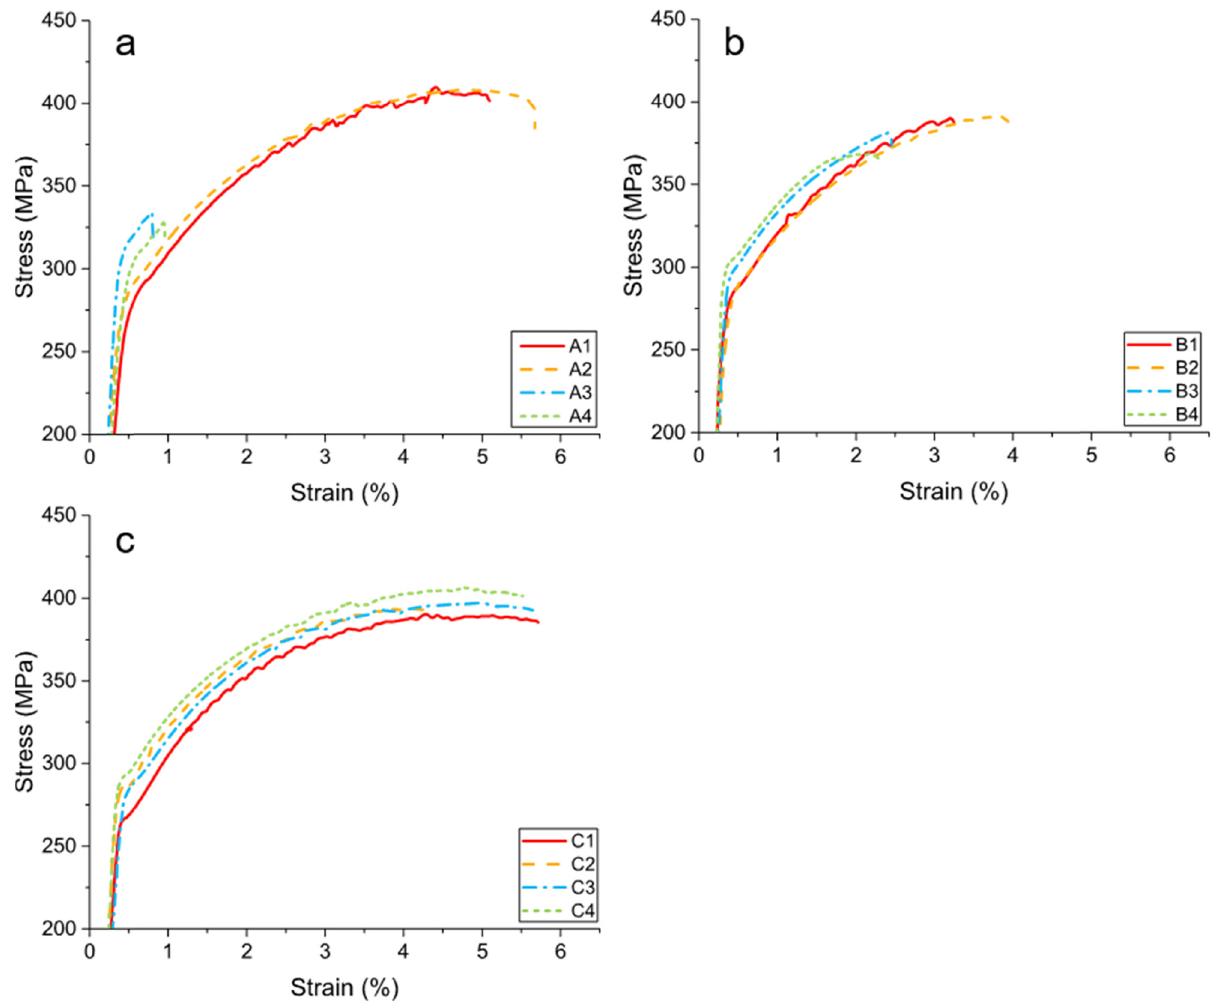
Figure 8: Typical stress – strain curves for ( a ) A, ( b ) B and ( c ) C